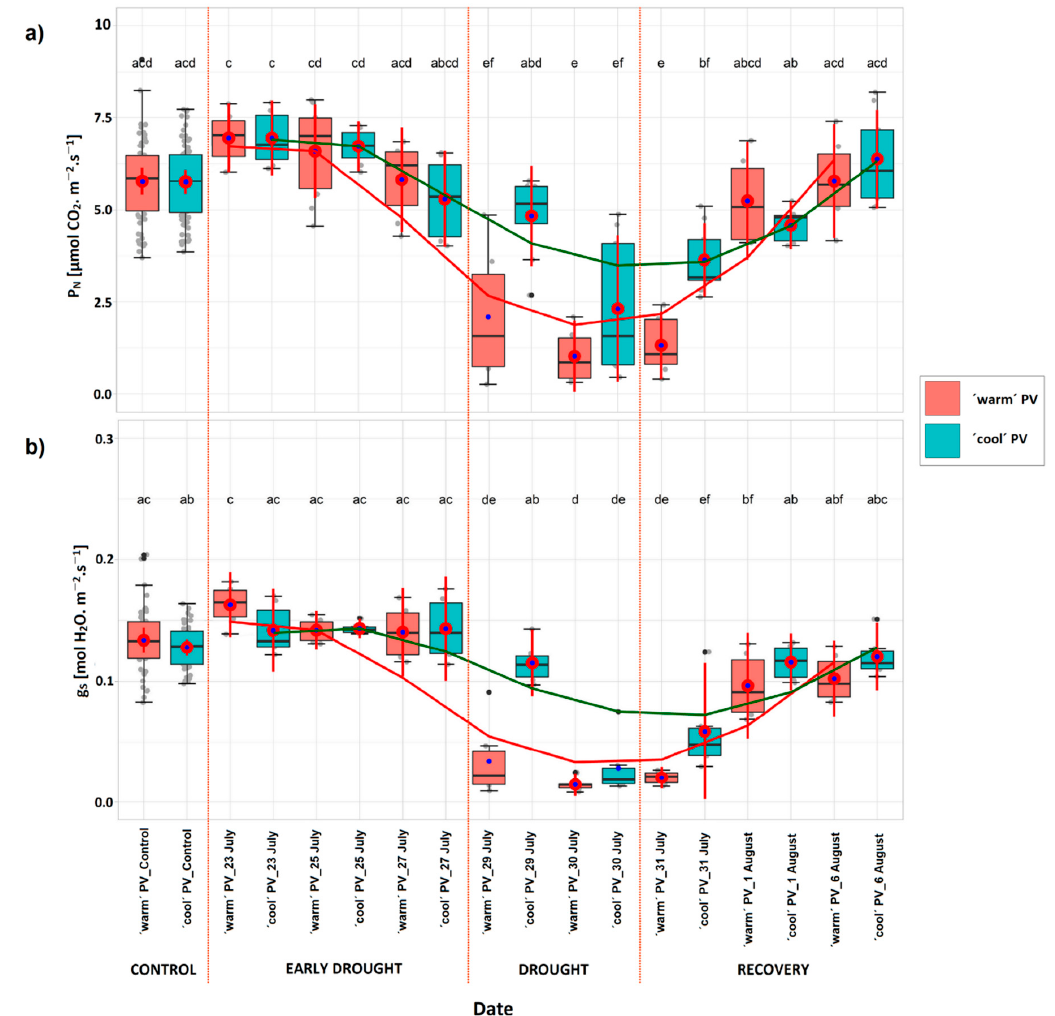
Figure 2. The courses of ( a ) the P N , and ( b ) g S during dehydration and recovery. Control variants represent the control values from the whole experiment. The graph’s bars with provenance means ± confidence interval (±95%). Different letters indicate statistically significant differences among groups. Provenances are identified by different colors: ´warm´ PV (red), ´cool´ PV (blue) .